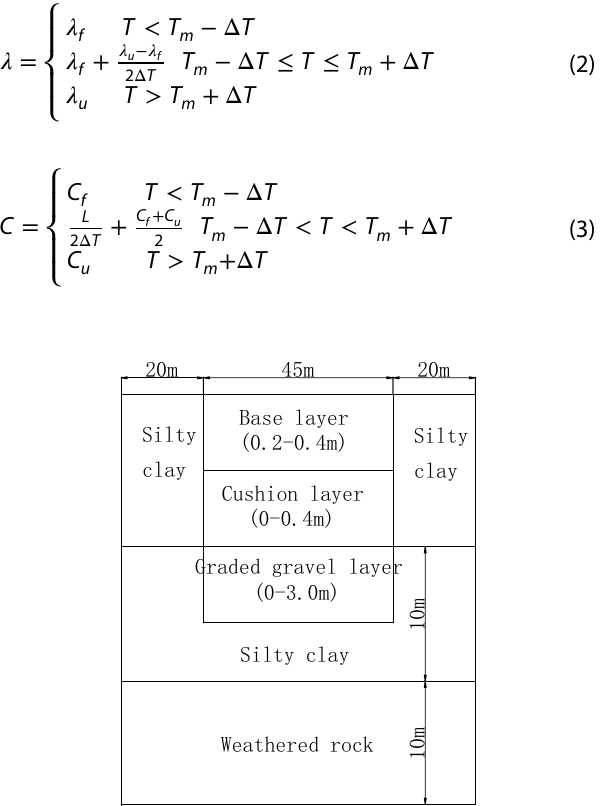
Table 1 Thermal parameters of pavement structure and subgrade